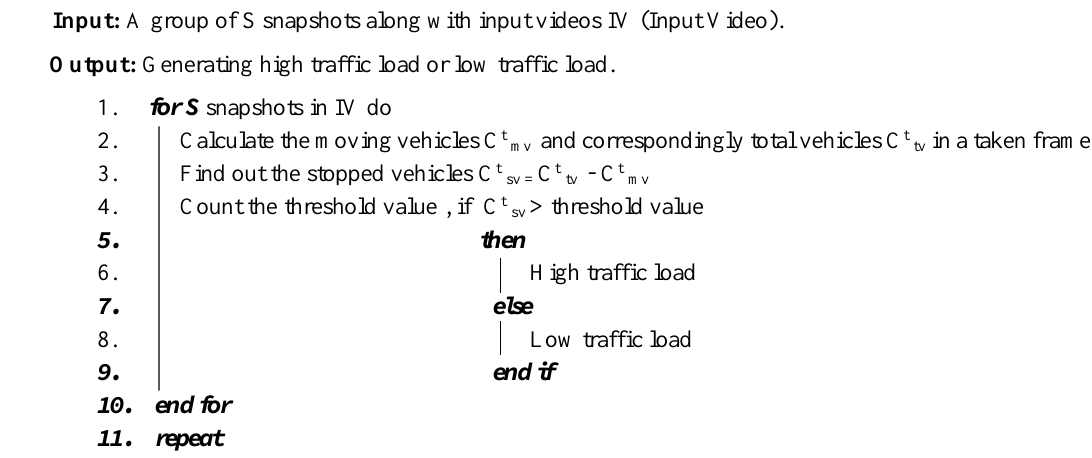
Figure 3. Estimating total vehicles count for sensor data analysis (eastbound and westbound traffic) Algorithm 1 depicts the usage of this Simulink model based on sensor data acquisition and analysis algorithm as shown below. Algorithm 1: IoT Sensor Data